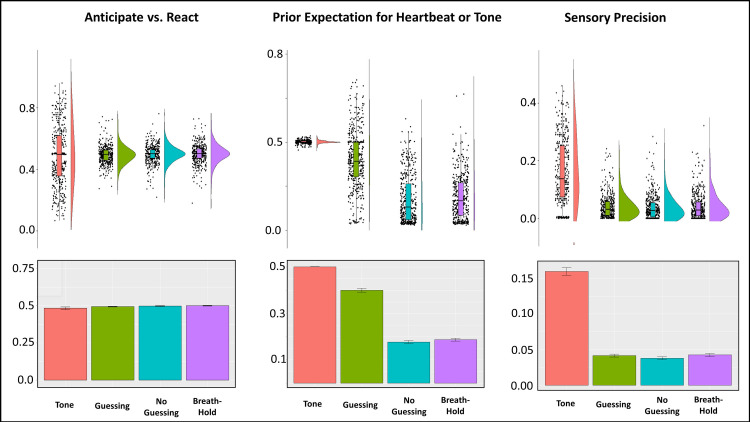
Bottom: Bar plots illustrating means and standard errors for model parameters by task condition across all participants. Prior beliefs for heartbeats were lower in the no-guessing and breath-hold conditions. Sensory precision (i.e., interoceptive precision for the heartbeat conditions or auditory precision for the tone condition) was much greater in the tone condition. This was expected given the unambiguous nature of this signal relative to the heartbeat signal. There were no significant differences in sensory precision between the heartbeat conditions. The Anticipate vs. React values revealed no mean differences between conditions. Top: For more complete data characterization, we also show raincloud plots depicting the same results in terms of individual datapoints, boxplots (median and upper/lower quartiles), and probability densities. These illustrate that, for the Anticipate vs. React parameter, nearly equally sized clusters of participants appeared to adopt more anticipatory (< .5) vs. reactive (>.5) strategies in the tone condition, and that prior beliefs remained unbiased (.5; with little variance) in the tone condition relative to the heartbeat tapping conditions.